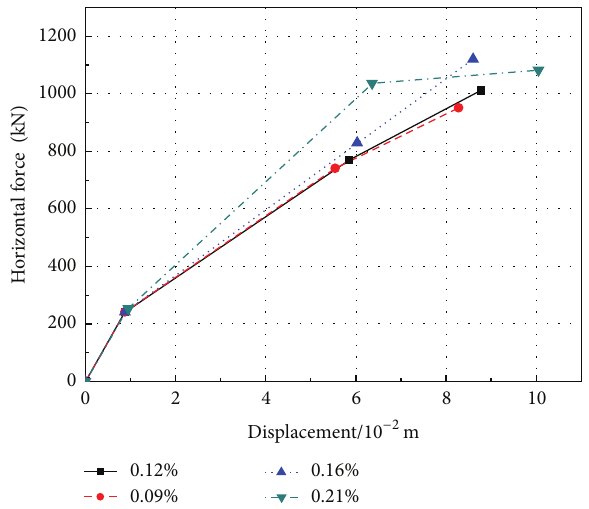
Figure 5: Key points on the skeleton curve of bottom section of PRC pier with different prestressed tendon ratios.